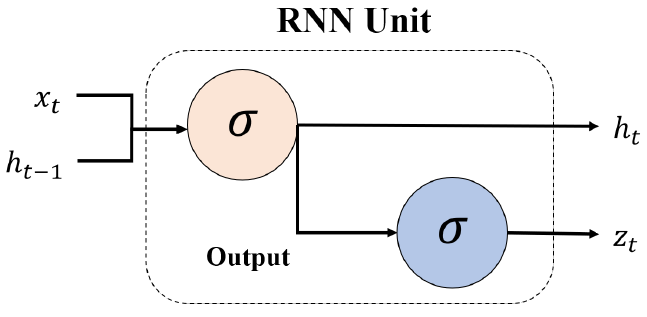
Figure 1. RNN unit.